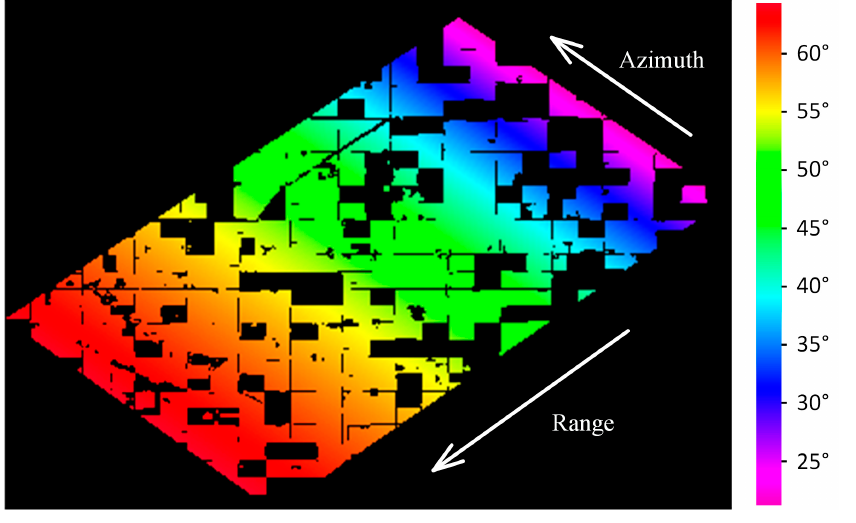
Figure 3. Local incidence angles of the samples. Table 2. Number of pixels of each crop.